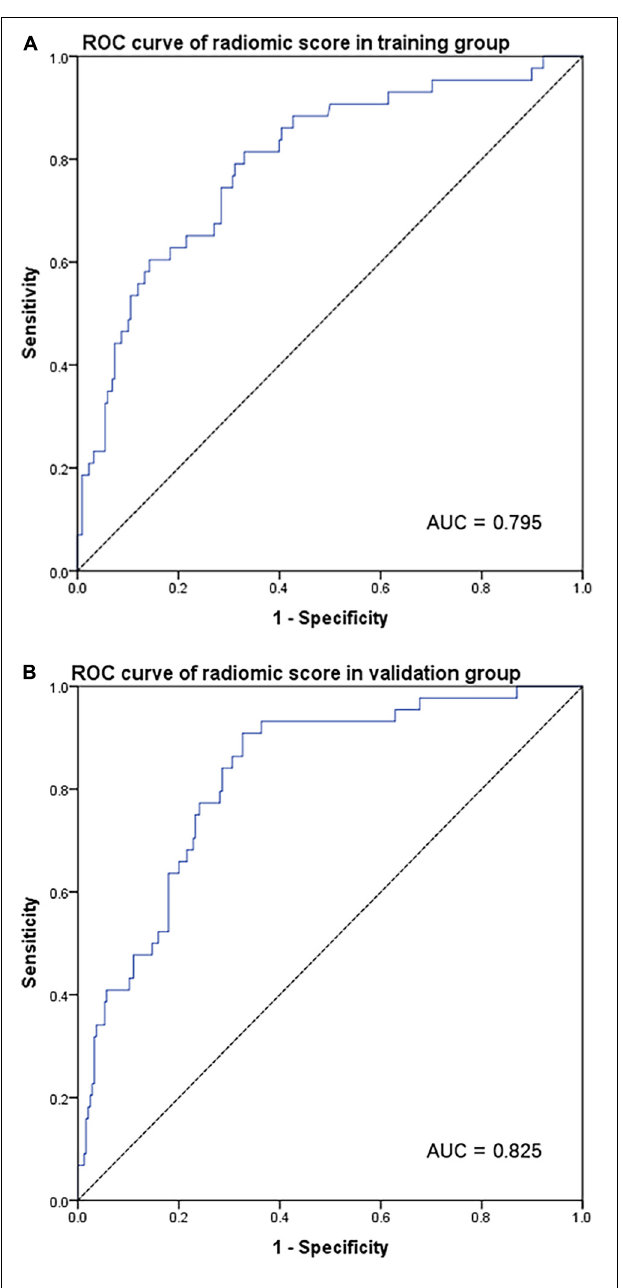
FIGURE 2 | ROC curve for radiomic score according to original sarcopenia in the training group (A) and validation group (B)